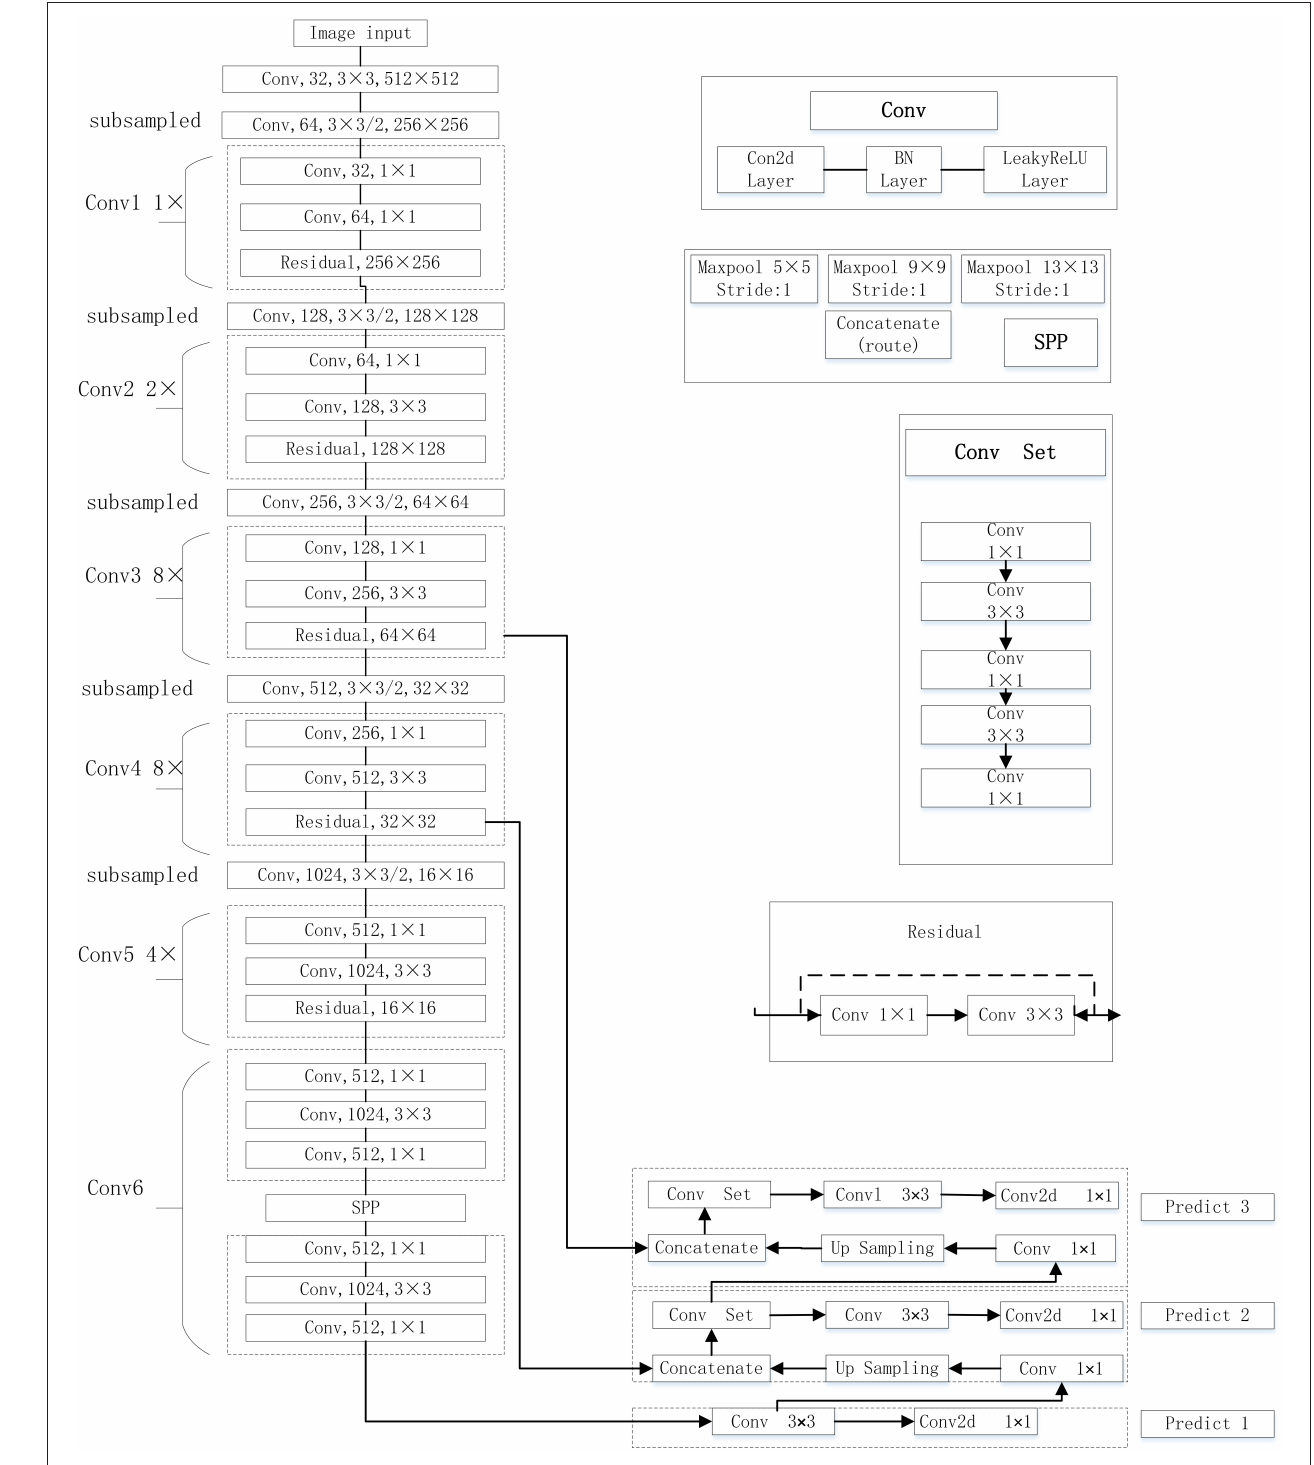
FIGURE 3 | The improved YOLOv3 network proposed in this work.